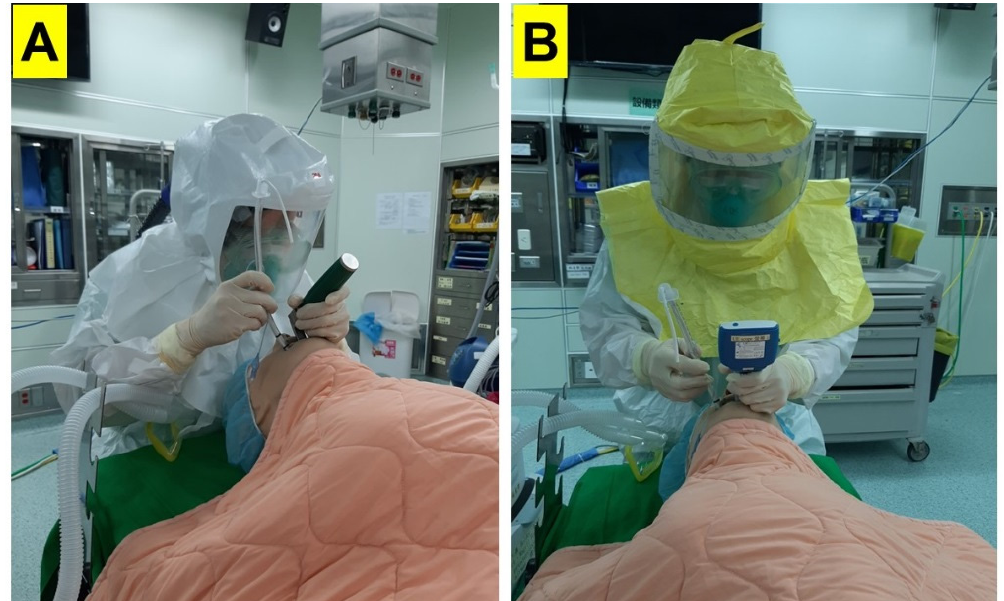
Figure 4. Proximity of the anesthesia provider to the patient’s airway during: ( A ) direct laryngoscopy, ( B ) indirect laryngoscopy using a videolaryngoscope (Courtesy photos reproduced from Cell Transplantation, SAGE Journals).